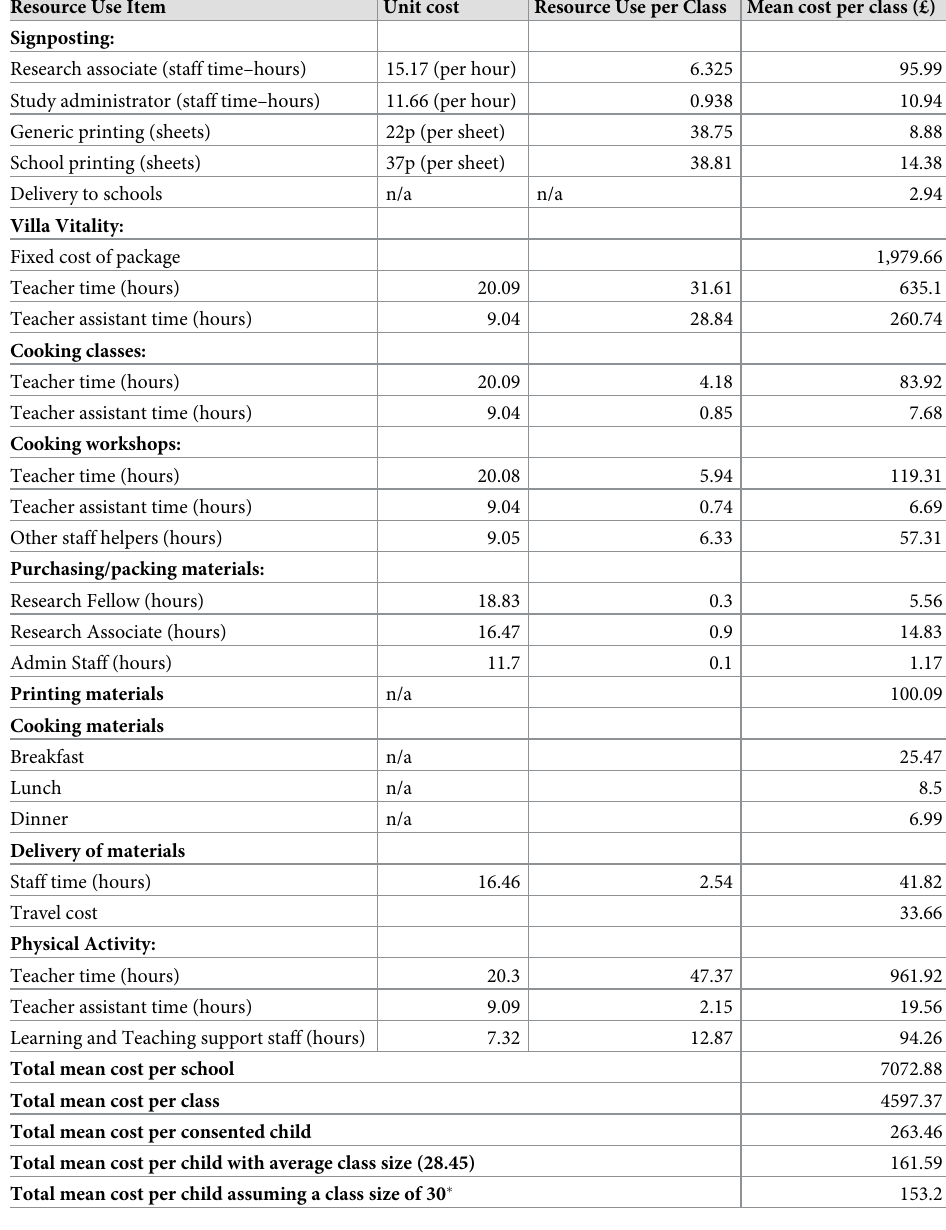
Table 3. Mean resource use and costs per class to deliver the 12-month intervention. Resource Use